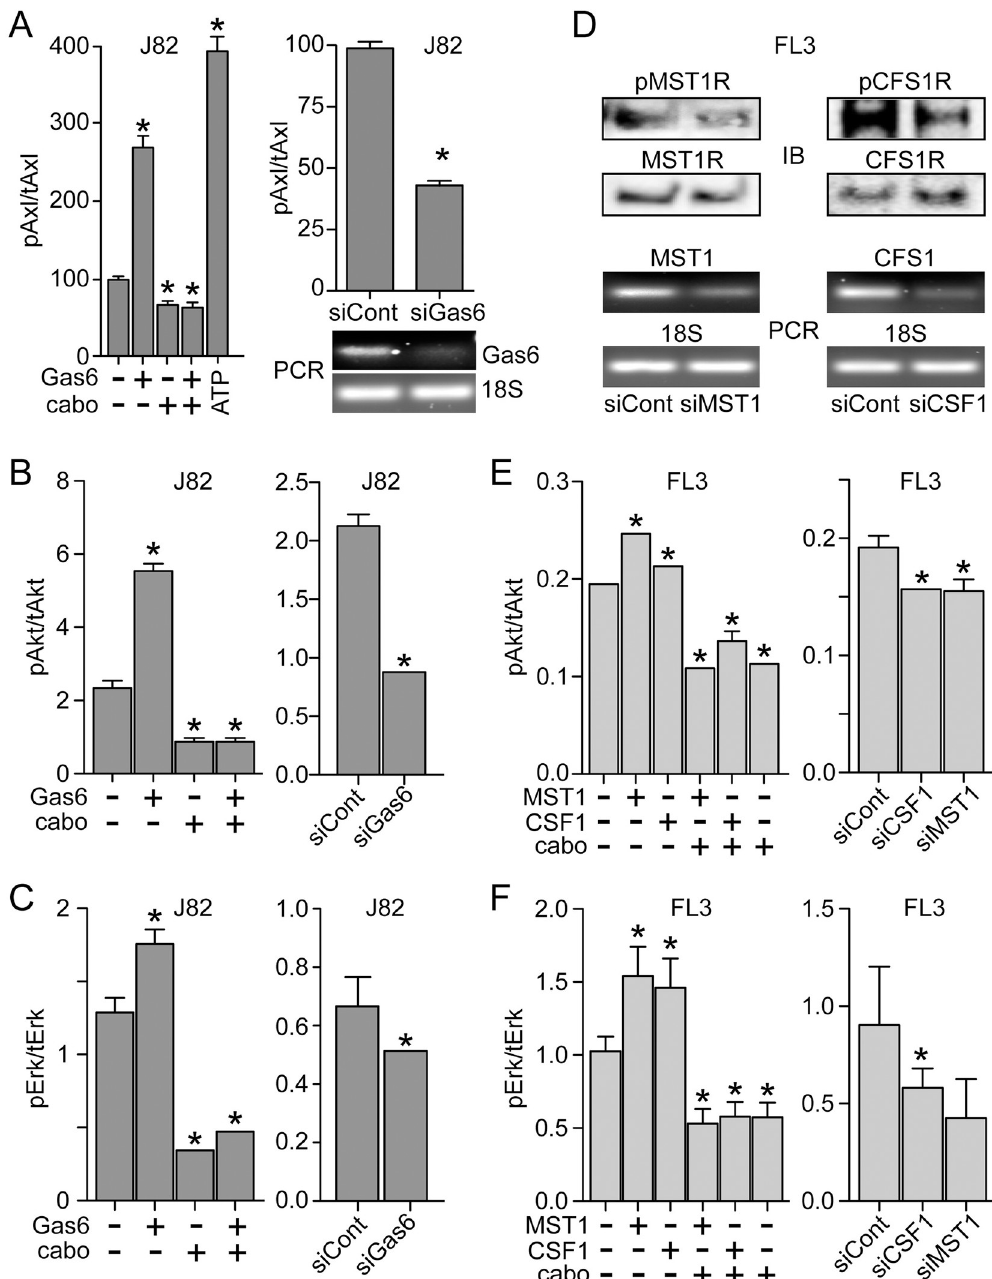
Fig 5. Autocrine RTK signaling in BCa cell lines. (A) Left: Axl kinase activation (phospho-Axl/total-Axl protein, pAxl/ tAxl), as determined by 2-site immunoassay, in serum-deprived J82 cells treated with Gas6 (5.7 nM, 1 h at 37˚C) in the presence or absence of cabozantinib (cabo; 300 nM), relative to untreated cells. Maximum possible Axl kinase activation was measured by adding ATP during the immunoassay (20 micromolar, 20 min at 25˚C) of lysates prepared from untreated J82 cells. Right top: Axl kinase activation (pAxl/tAxl) in serum-deprived J82 cells that had been transfected with GAS6 siRNA or scrambled (control) siRNA. In both panels, values are the mean +/- SD from triplicate samples; asterisks indicate significant difference from untreated control (p < 0.05). Right bottom: ethidium bromide visualization of PCR products specific for GAS6 mRNA (upper panel) vs 18S rRNA (lower panel) resolved by agarose gel electrophoresis. (B) Left: Akt kinase activation (pAkt/tAkt), as determined by 2-site immunoassay, in serum-deprived J82 cells treated with Gas6 (5.7 nM, 1 h at 37˚C) in the presence or absence of cabozantinib (cabo; 300 nM), relative to untreated cells. Right: Akt kinase activation (pAkt/tAkt) in serum-deprived J82 cells that had been transfected with Gas6 siRNA or scrambled (control) siRNA. In both panels, values are the mean +/- SD from triplicate samples; asterisks indicate significant difference from untreated